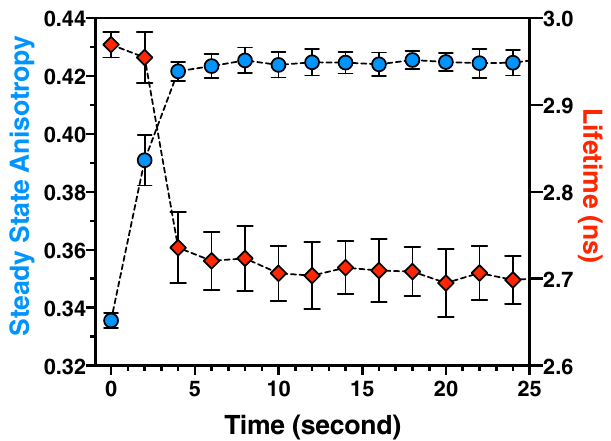
Fig.4|DecreaseinV-CaMKIIhomo-FRETprecedesCaMKII – NR2Bhetero-FRET. High temporal resolution in vitro binary-FRET was performed using V-CaMKII activated in the presence of mCherry-tagged NR2B binding fragment in a solution containing5%glycerol.Eachpointismean±SD, n =6independentsamples.Source data are provided as a Source Data fi le. Representative anisotropy and lifetime decay traces areshown inSupplementary Fig. 3, asare the six independent steady- state anisotropy and average lifetime traces used to calculate the average values shown